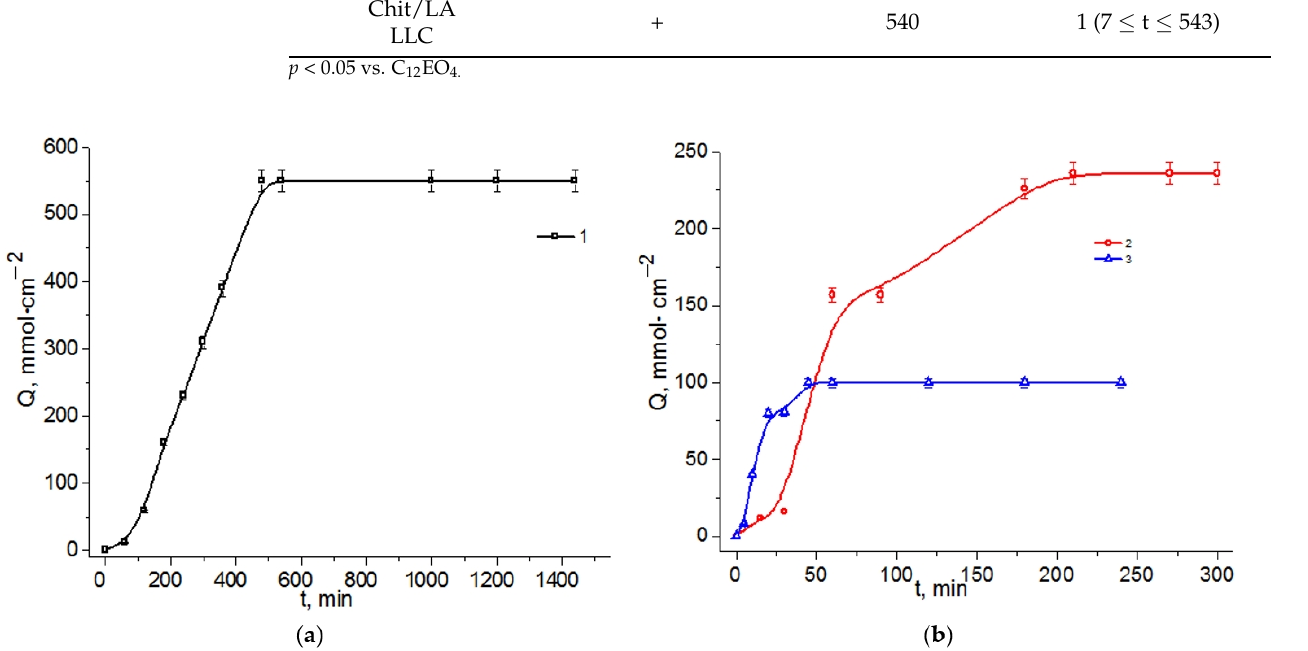
Figure 6. Release profiles of riboflavin from ( a ) Chit/LA 15/85 wt. %—1; ( b ) Chit/LA 5/95 wt. % (C LA = 2 wt. %)—2, C 12 EO 4 /(Chit:LA) 50/50 wt.